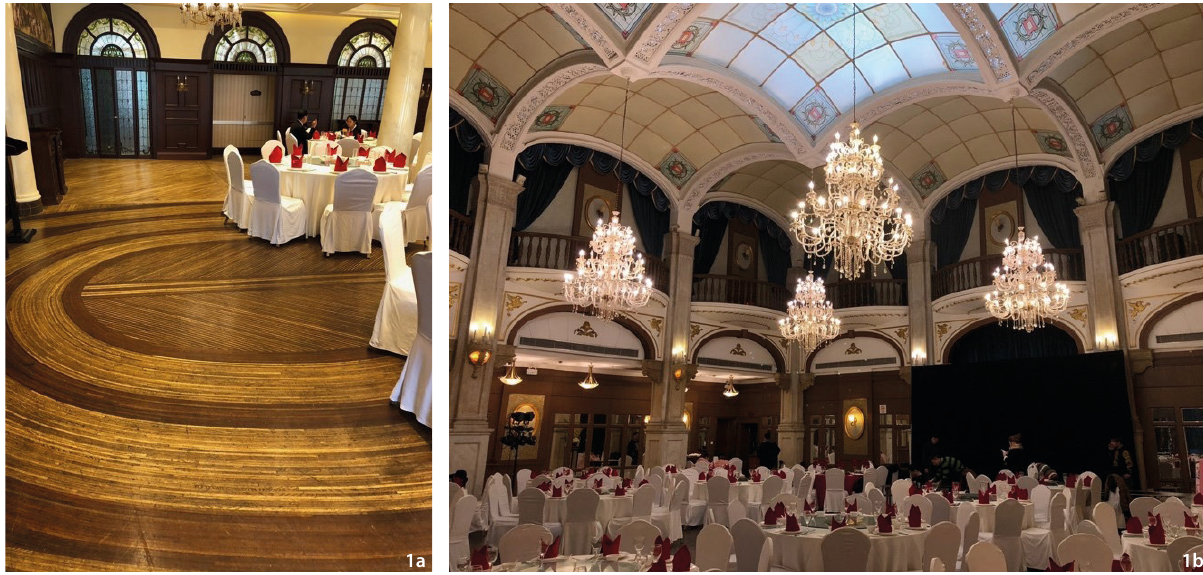
1a Figure 1a and Figure 1b Photos of the Astor House ballroom showing the original wooden dance floor and the original skylight (the chandeliers are newer additions) (Source: the author).